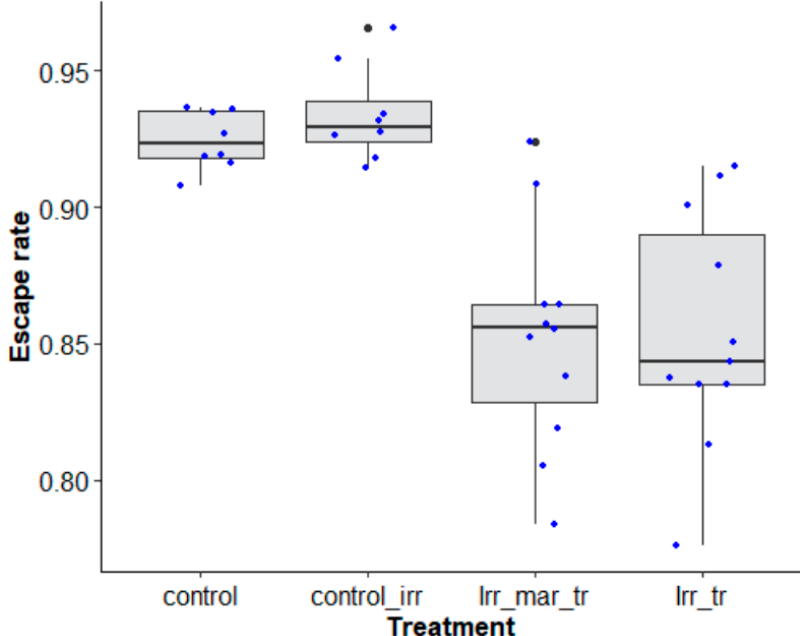
Figure 9. Escape rates according to mosquito treatment (control, marked and unmarked) of Aedes aegypti , Senegal strain, transported over a long distance. Control groups (control and control_ irr = control irradiated) were assessed at the laboratory of origin (Austria) while other treatments (Irr_ mar_ tr = irradiated_ marked- transported and Irr_ tr = irradiated_ unmarked- transported) were assessed at the receiving laboratory (Senegal). Black bars indicate the median. The upper and lower limits of each box indicate the interquartile range. Each blue dot represents a value of the observed escape rate per replicate. Black dots represent